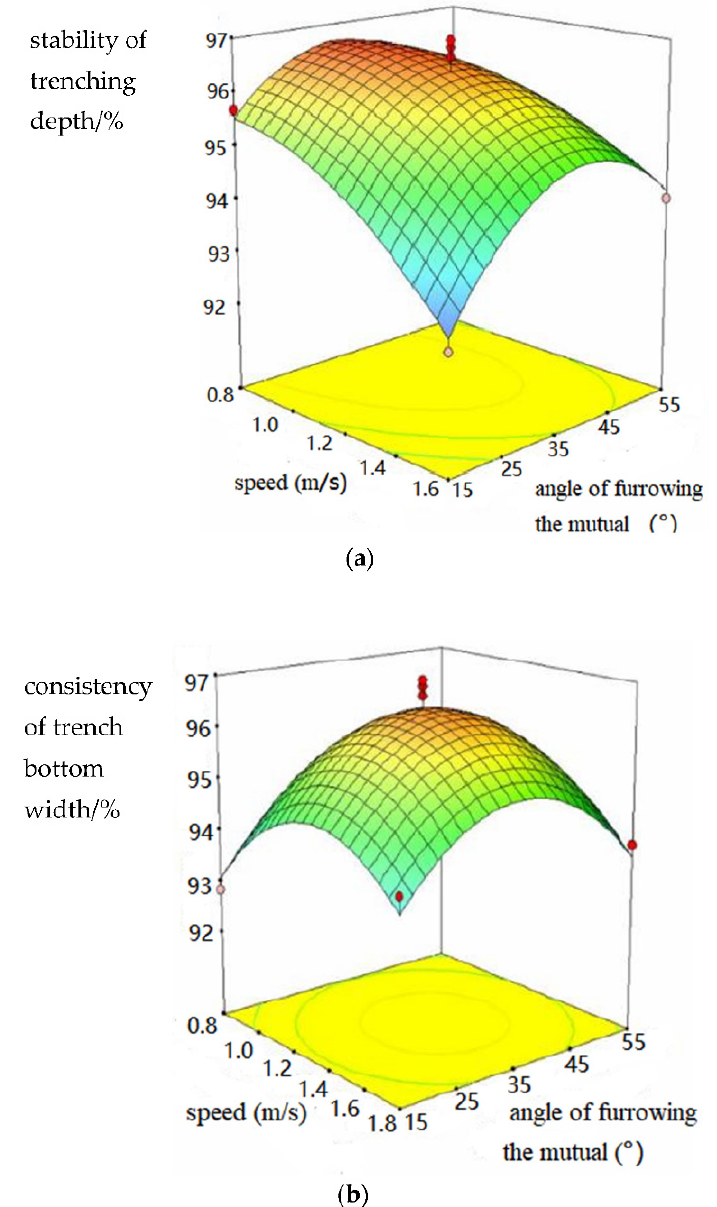
Figure 9. Response surface diagram of the interaction. ( a ) Influence of the interaction of trenching depths on the stability. ( b ) Effect of the interaction of trench bottom width on consistency.